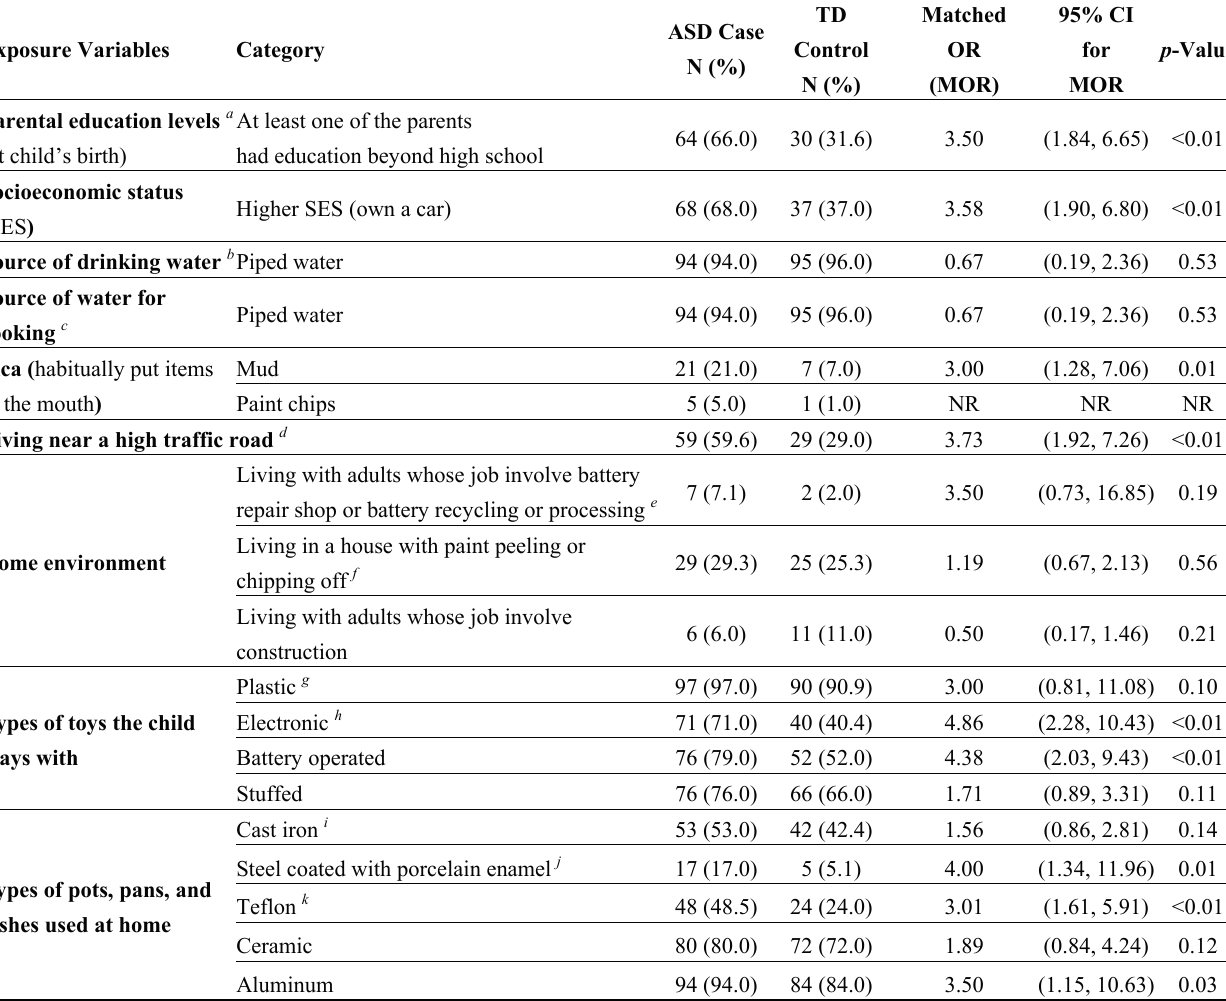
Table 2. Association between potential confounders and ASD case status using Conditional Logistic Regression (CLR) (200 children or 100 matched